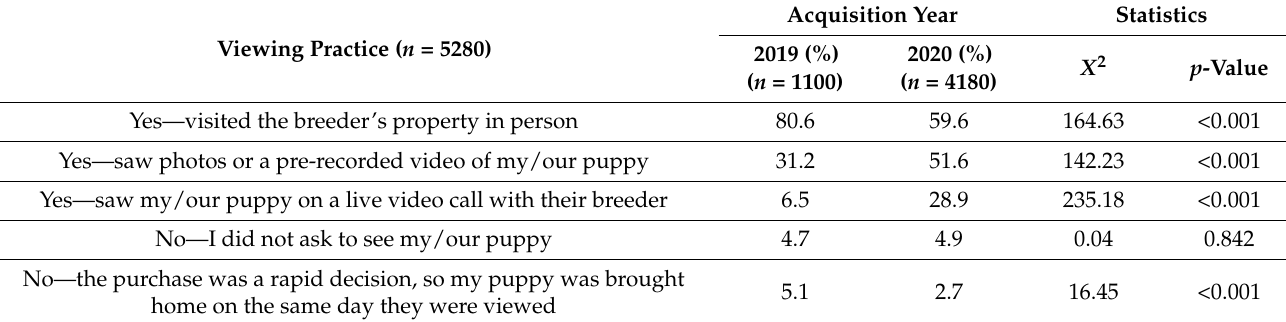
owners ( n = 1100) and Pandemic Puppy owners ( n = 4180) in the